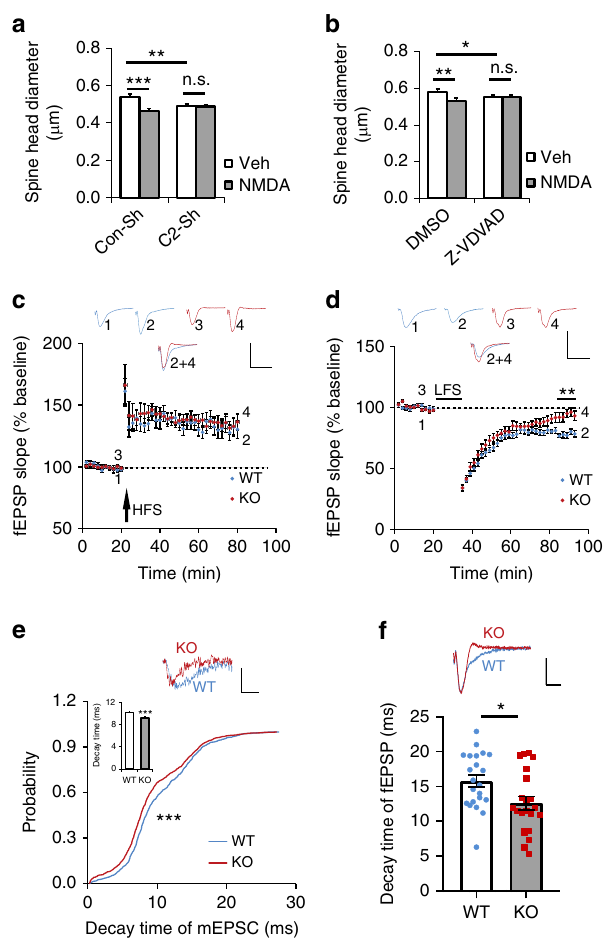
Fig. 3 Caspase-2 de fi ciency impairs NMDA-induced spine shrinkage, diminishes LTD expression and alters decay kinetics. a , b Effects of caspase-2 knockdown or inhibition on spine head size in cultured rat hippocampal neurons. Neurons were transfected with constructs expressing Con-shRNA (Con-sh) or Casp2 shRNA (C2-sh) on DIV14. Alternatively, the caspase-2 inhibitor Z-VDVAD-FMK (10 μ M) or DMSO was added to neuronal cultures on DIV21. For visualization of spines, neurons were transfected with a construct expressing EGFP-actin on DIV14. On DIV28, neurons were treated with vehicle or 40 μ M NMDA for 5 min and fi xed 30 min after NMDA treatment for analysis of dendritic spines. Con-sh and Veh, 281 spines from 10 neurons; C2-sh and Veh, 292 spines from 10 neurons; Con-sh and NMDA, 178 spines from 6 neurons; C2-sh and NMDA, 356 spines from 12 neurons; DMSO and Veh, 369 spines from 13 neurons; Z-VDVAD and Veh, 308 spines from 11 neurons; DMSO and NMDA, 208 spines from 7 neurons; Z-VDVAD and NMDA, 299 spines from 10 neurons. c Normal LTP expression at Schaffer collateral-CA1 synapses of Casp2 KO mice, as revealed by measurement of fi eld excitatory postsynaptic potentials (fEPSP). LTP was induced with high-frequency stimulation (HFS). WT, 10 slices from 6 mice; KO, 11 slices from 7 mice. Scale bars, 1 mV (vertical) and 20 ms (horizontal). d Impaired LTD expression at Schaffer collateral-CA1 synapses of Casp2 KO mice. LTD was induced with low-frequency stimulation (LFS). WT, 13 slices from 5 mice; KO, 14 slices from 8 mice. Scale bars, 1 mV (vertical) and 20 ms (horizontal). e Cumulative probability of mEPSC decay time in CA1 pyramidal neurons of WT and Casp2 KO mice. Mean decay time was shown in the bar graph. WT, 840 events from 17 neurons in 5 mice; KO, 991 events from 20 neurons in 6 mice. Scale bars, 20 pA (vertical) and 10 ms (horizontal). f Decay time of fEPSP at CA1 pyramidal neurons. WT, 22 slices from 9 mice; KO, 22 slices from 11 mice. Scale bars, 0.5 mV (vertical) and 10 ms (horizontal). Data are expressed as mean ± SEM. Data were analyzed using two-tailed Student ’ s t test, except e